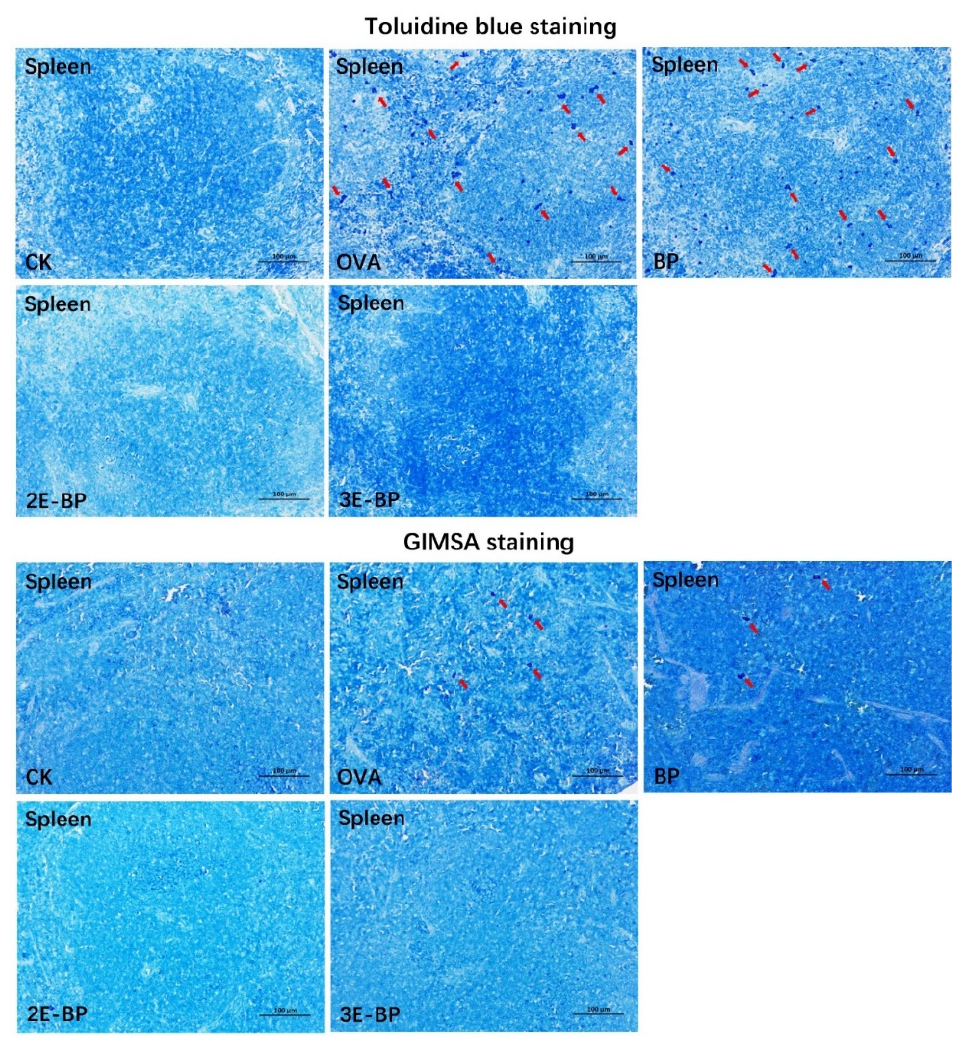
Figure 2. Histopathological changes in mouse spleen in different treatment groups. Mast cells and granulocytes stained separately with toluidine blue (TB) and GIMSA are marked with red arrows.